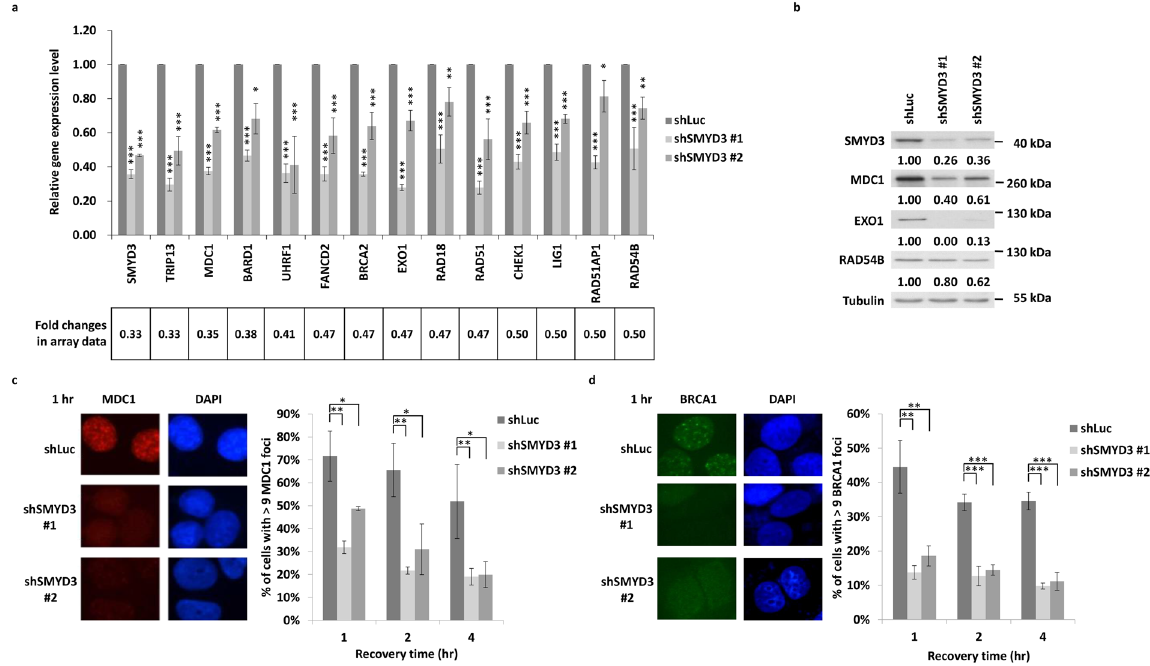
Figure 4. SMYD3 knockdown downregulates HR gene expressions. ( a ) The confirmation of the microarray analyses for the expressions of candidate genes in the shSMYD3/shLuc dataset using qRT-PCR. The fold changes of each gene expression in the microarray data were listed below. * P < 0.05, ** P < 0.01, *** P < 0.001 vs. shLuc control. ( b ) Western blot analyses of SMYD3, MDC1, EXO1 and RAD54B in shLuc and shSMYD3 MCF7 cells. Tubulin was used as a loading control. The ratio of individual protein relative to the loading control tubulin was indicated below. ( c , d ) DNA repair foci formation of MDC1 foci ( c ) and BRCA1 foci ( d ) formation at indicated times after 1.67 Gy IR treatment in shLuc or shSMYD3 MCF7 cells. * P < 0.05. ** P < 0.01. *** P < 0.001. All values in the histograms were means ± SD of triplicates and data were representative of n ≥ 3 for each